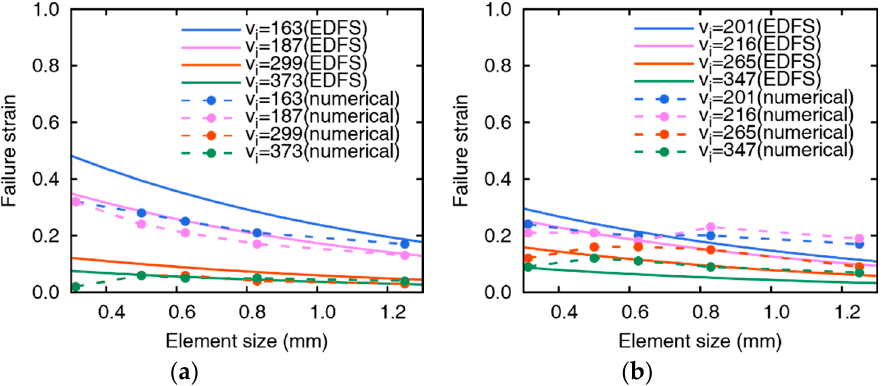
Figure 9. Comparison of numerically obtained failure strain and damage model ( t pl = ( a ) 5 mm and ( b ) 10 mm, v ref = 110.0 m /s ).